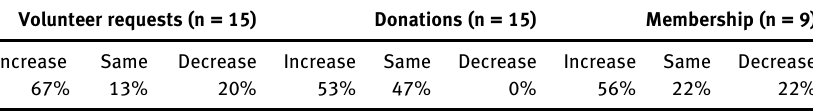
Table  : Changes in public